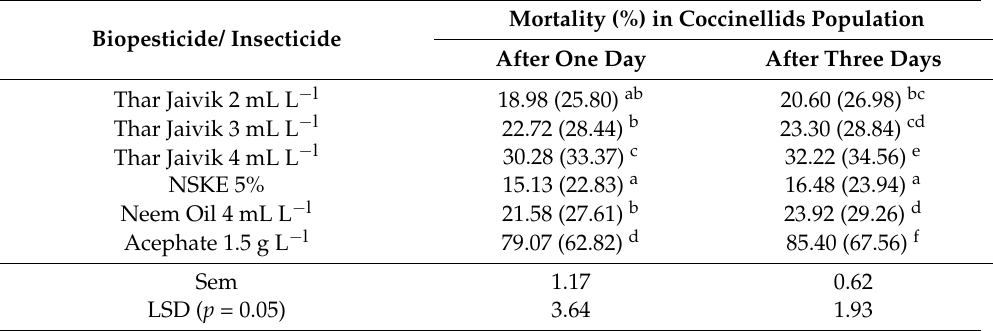
Table 4. Efficacy of different concentrations of “Thar Jaivik 41 EC” and other biopesticides against coccinellids on citrus plant in field conditions (pooled data, 2018 and